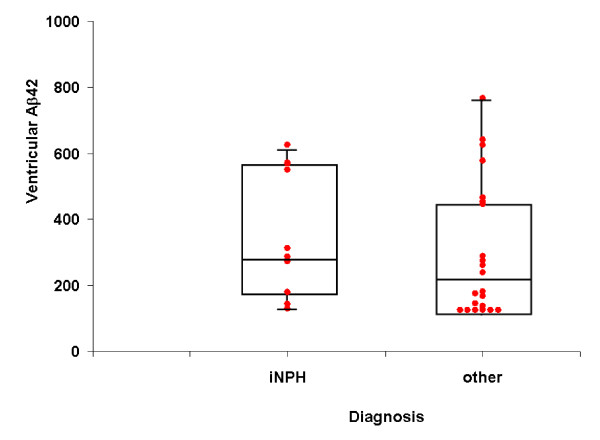
Comparison of ventricular Aβ42 levels between iNPH and other hydrocephalus. The space between 2 horizontal lines is the interquartile range. The boxes represent the 25th, 50th and 75th percentiles (values are expressed in pg/ml).